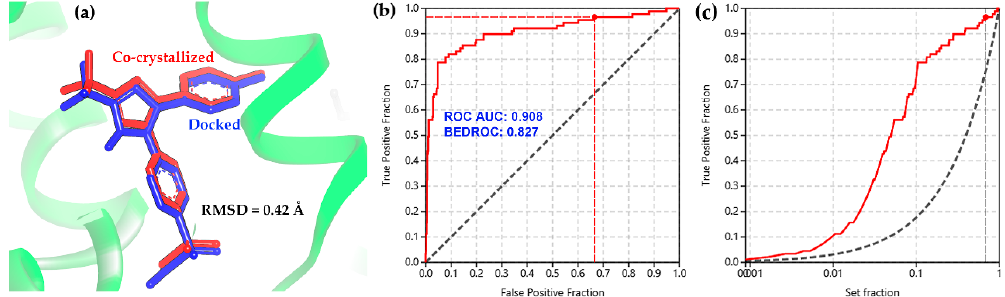
Figure 2. ( a ) Docked (blue sticks) and co-crystallized (red sticks) superposition of celecoxib after re-docking within the active site of COX-2. ( b ) Receiver operating characteristic (ROC) and ( c ) enrichment curve for the benchmarking of the docking protocol using a set of active compounds and decoys against COX-2 (3LN1).